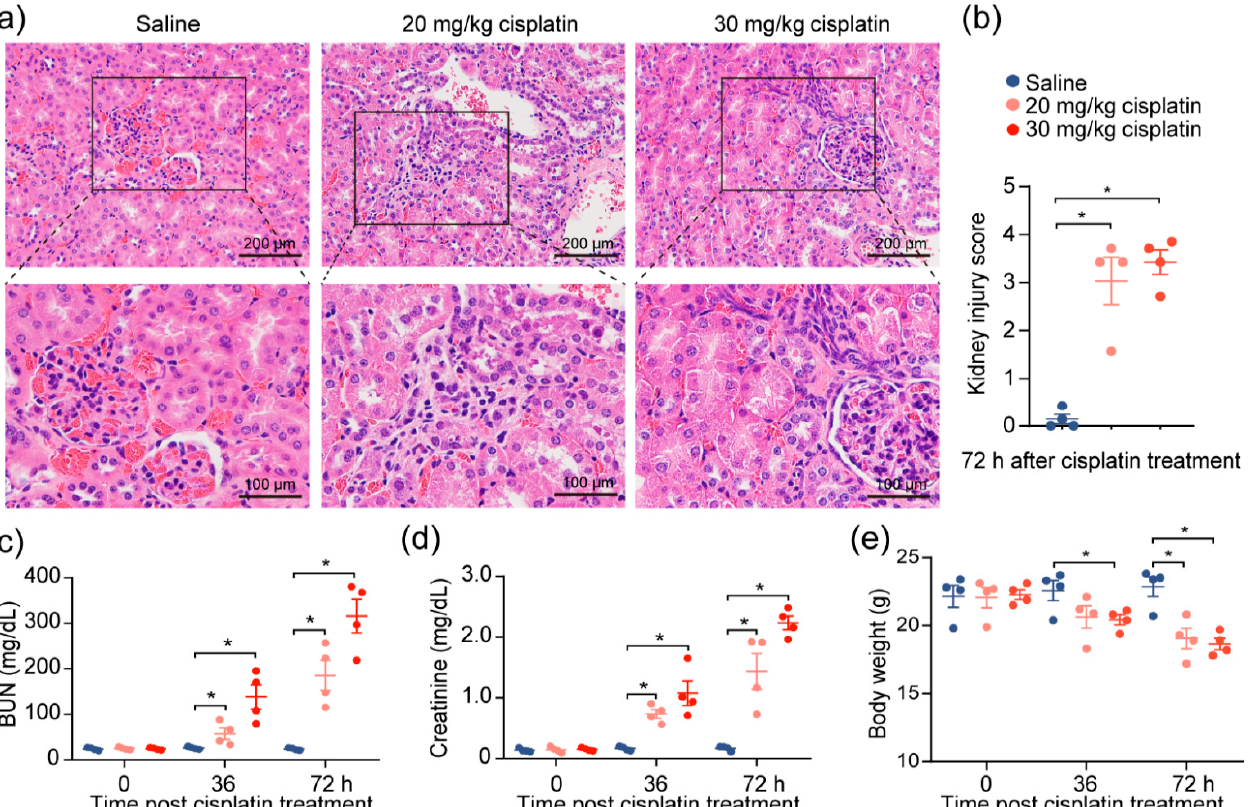
Figure 1. Cisplatin induces acute kidney injury. Mice were intraperitoneally injected with one dose of cisplatin, at 20 mg/kg or 30 mg/kg, for 72 h. Body weight, levels of BUN, and creatinine in serum were determined at 36 and 72 h. At 72 h, spleens and kidneys from mice were collected for pathology analysis and immunophenotyping, respectively. ( a ) Representative images, and ( b ) tubular injury quantification of H&E staining in kidney specimens from mice treated with 30 mg/kg cisplatin for 72 h ( n = 4). ( c – e ): levels of serum BUN ( c ), creatinine ( d ), and body weight ( e ) ( n = 4. * p < 0.05).